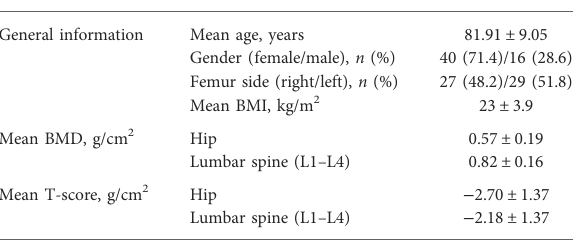
TABLE 1 The characteristics of the patients with a DXA at the hip and lumber spine.